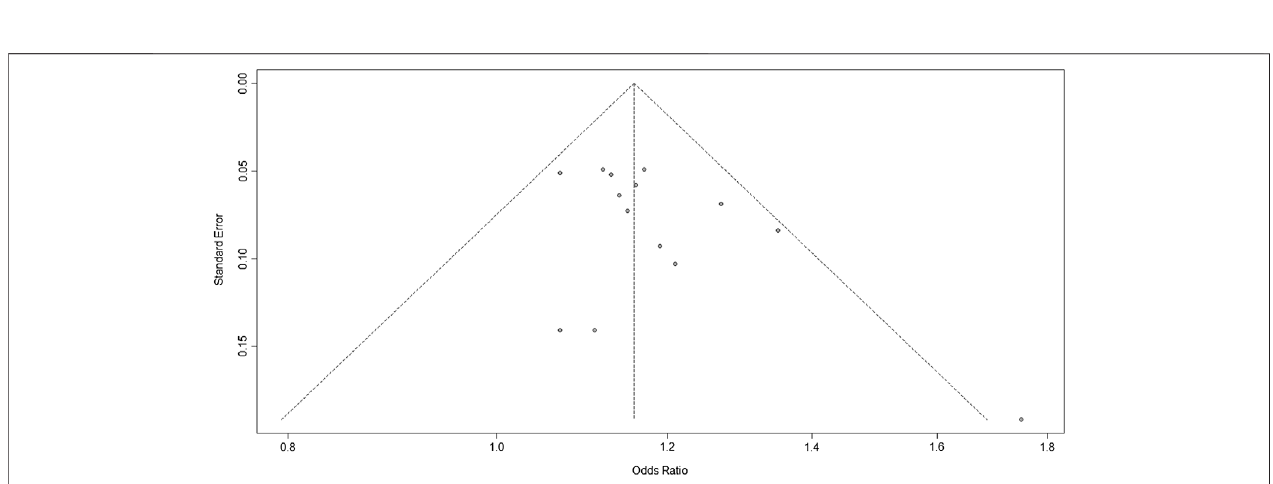
Frontiers in Genetics |